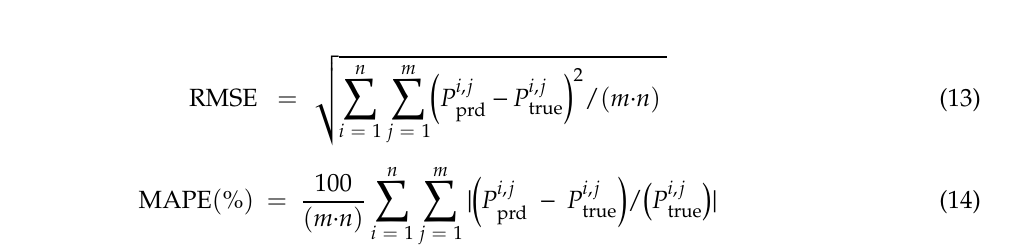
Figure 5. The NN sim -predicted compositions versus the true compositions of 11 phytoplankton species in the randomly selected 10% of the simulation dataset (there are 20,000 spectra). The solid line is the 1:1 line.